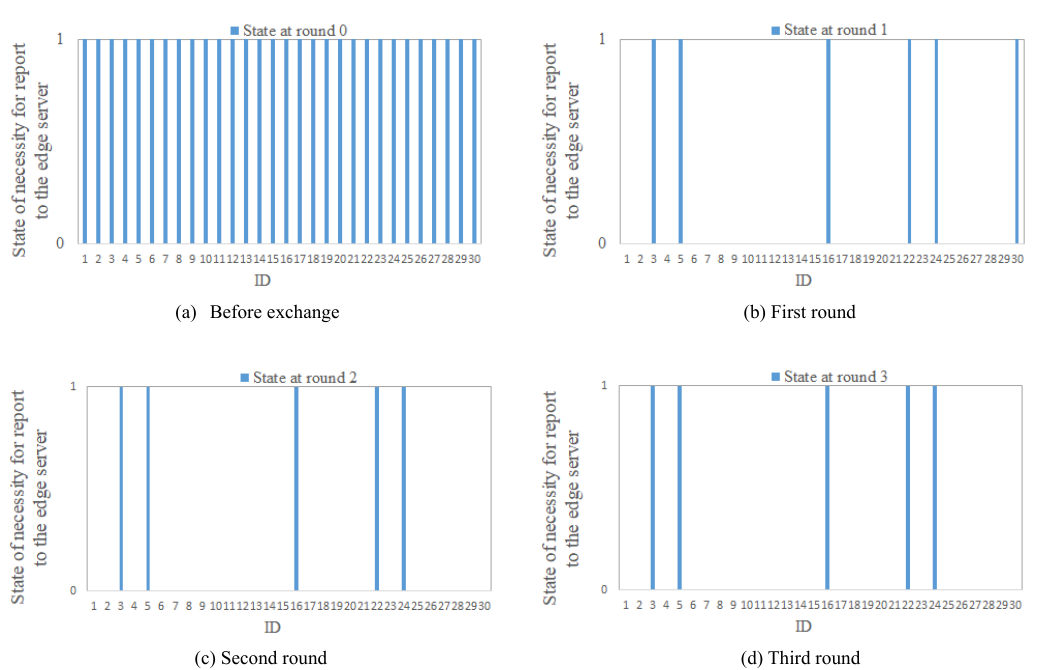
Figure 5. Number of necessary reports to the edge server in Scenario 1 regarding the proposed scheme (State 1 refers to the state in which the vehicle needs to report to the edge